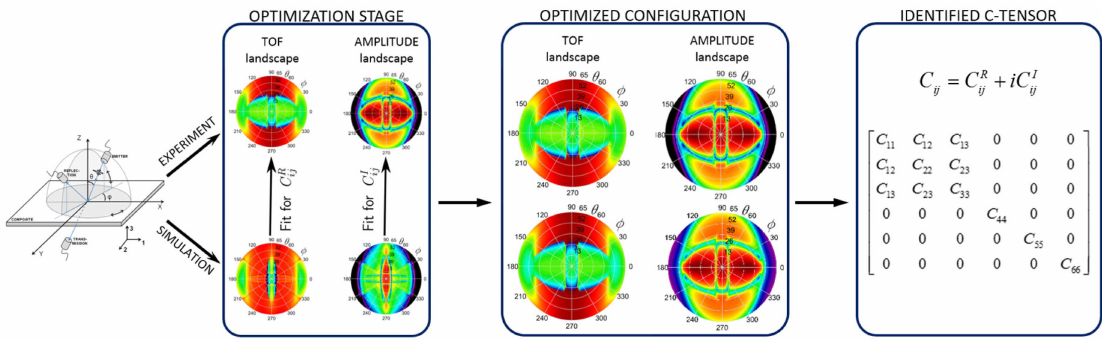
Figure 15. Roadmap for the identification of viscoelastic C-tensor using both TOF and amplitude P-UPS